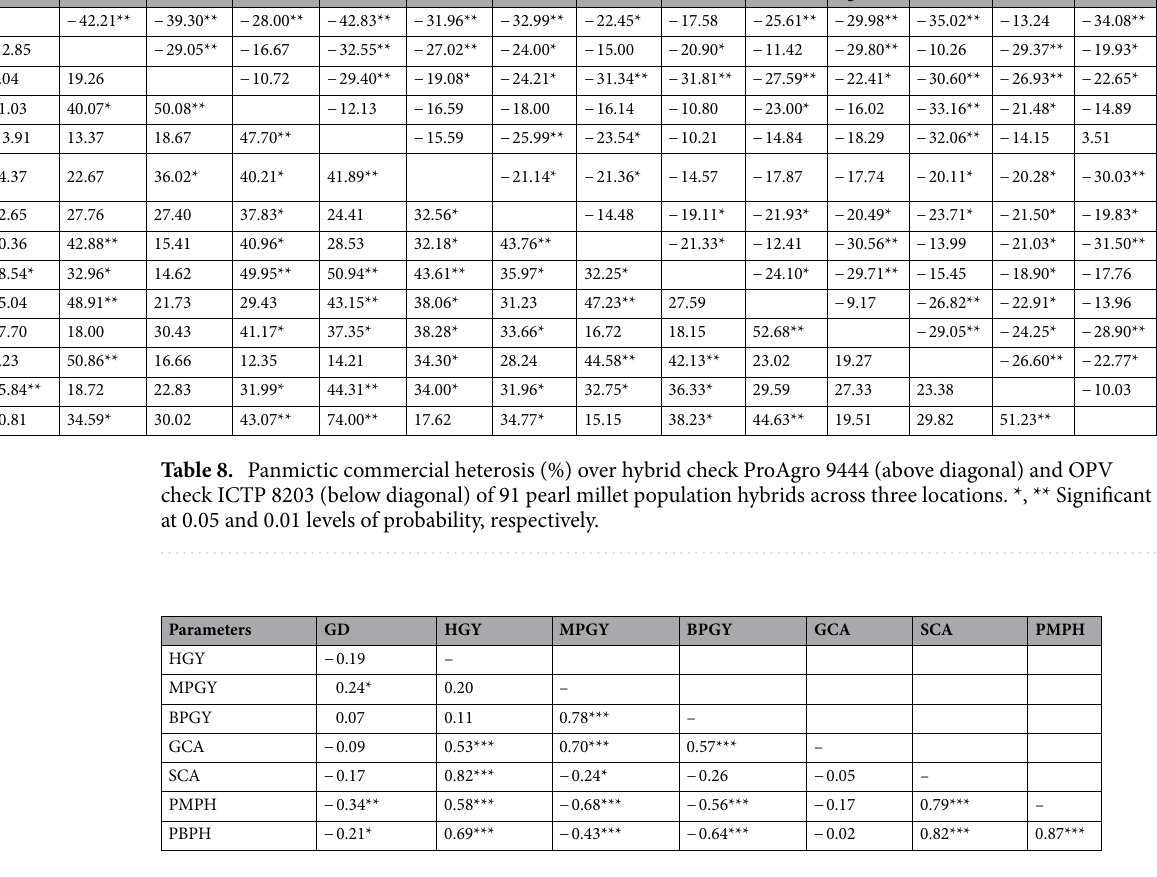
Table 9. Correlation between genetic distance (GD), hybrid performance, combining ability effects and heterosis for grain yield. GD Genetic distance, HGY Hybrid grain yield, MPGY Mid-parent grain yield,